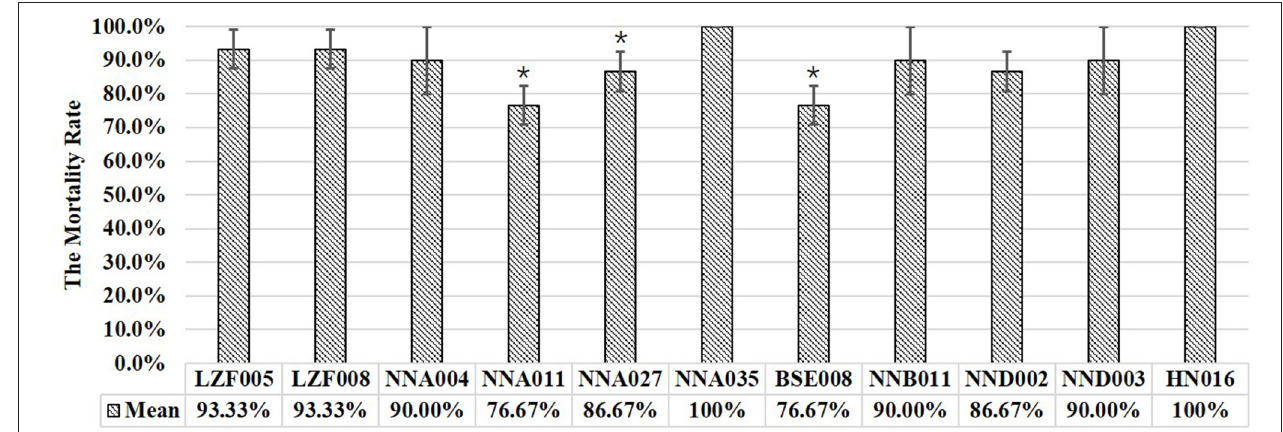
FIGURE 1 | The results of experimental infection of tilapia with human ST23 GBS isolates. Mean represented the average cumulative mortality of three parallel groups. *Indicated significant difference with HN016 infection ( P < 0.05).